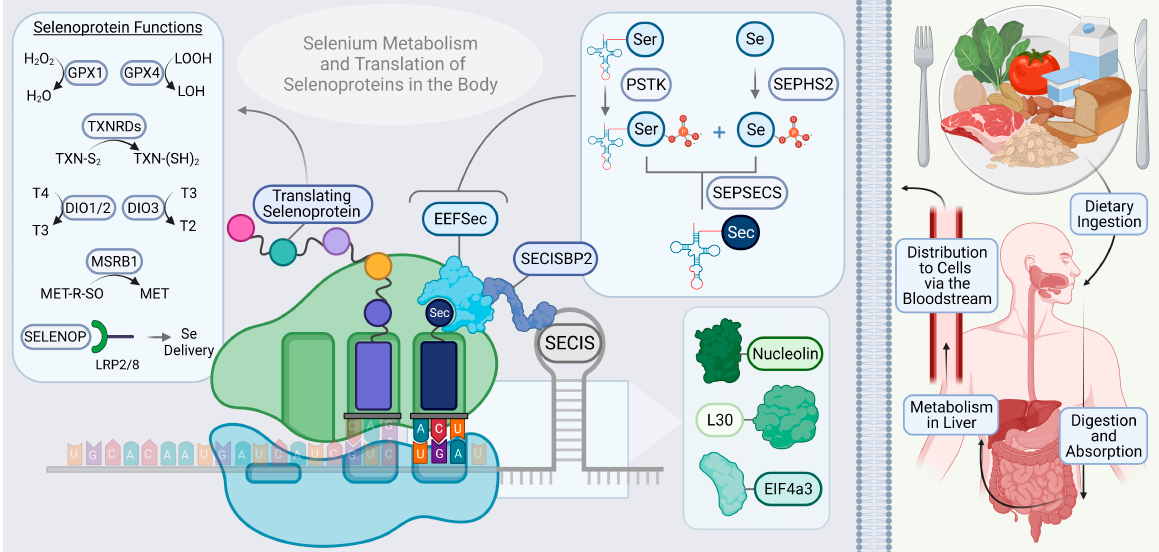
Figure 1. Diagram of dietary selenium metabolism and selenoprotein synthesis and function. Selenium is obtained through the diet and is commonly found in meats, eggs, dairy, grains, fruits, vegetables, nuts, and legumes. Following digestion and absorption through the gut, it is metabolized by the liver, and distributed throughout the body via the circulatory system. Inside the cell, selenophosphate synthetase 2 (SEPHS2) uses selenium (Se) to generate selenophosphate. PSTK (Protein serine threonine kinase) phosphorylates Ser-tRNASec, which is then converted into Sec- tRNASec by selenocysteine synthase (SEPSECS) using selenophosphate. The stem loop-containing selenocysteine insertion sequence (SECIS) in the selenoprotein mRNA is recognized by SECISBP2 (SECIS-binding protein 2), which helps stabilize the mRNA to allow for the recruitment of EEFSec (eukaryotic selenocysteine-specific elongation factor) and other members of the selenoprotein translation complex. The ribosomal protein L30, eukaryotic translation initiation factor a3 (eIFa3), and the nucleolus-resident phosphoprotein nucleolin have all been identified as SECIS-binding proteins, but their precise role in selenoprotein synthesis has not been well-elucidated [49] . The selenoproteins with the most well-characterized mechanisms of action include the glutathione peroxidases (GPXs), which reduce hydrogen peroxide (H 2 O 2 ) and lipid hydroperoxides (LOOHs), the thioredoxin reductases (TXNRDs), the iodothyronine deiodinases (DIOs), which activate/de-activate thyroid hormones, methionine-R-sulfoxide reductase B1 (MSRB1), and the Se carrier selenoprotein P (SELENOP), which delivers selenium to cells through its interactions with LRP2 (low density lipoprotein receptor-related protein 2; also called megalin) and